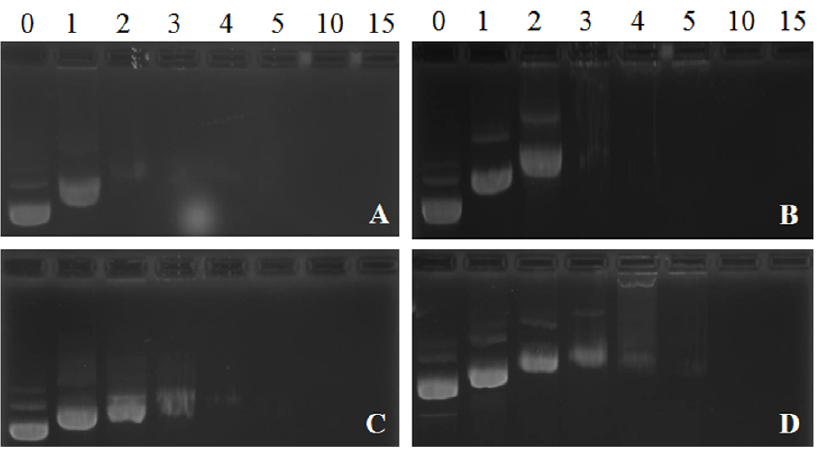
Figure 3. Electrophoretic mobility of DNA in cholesterol-peptide/DNA complexes at N/P ratio of 0, 1, 2, 3, 4, 5, 10 and 15 respectively. Panel A. Ch-R5H5/DNA complexes, Panel B. Ch-R3H3/DNA complexes. Panel C. Ch-R5/DNA complexes. Panel D. Ch-R3/DNA complexes.